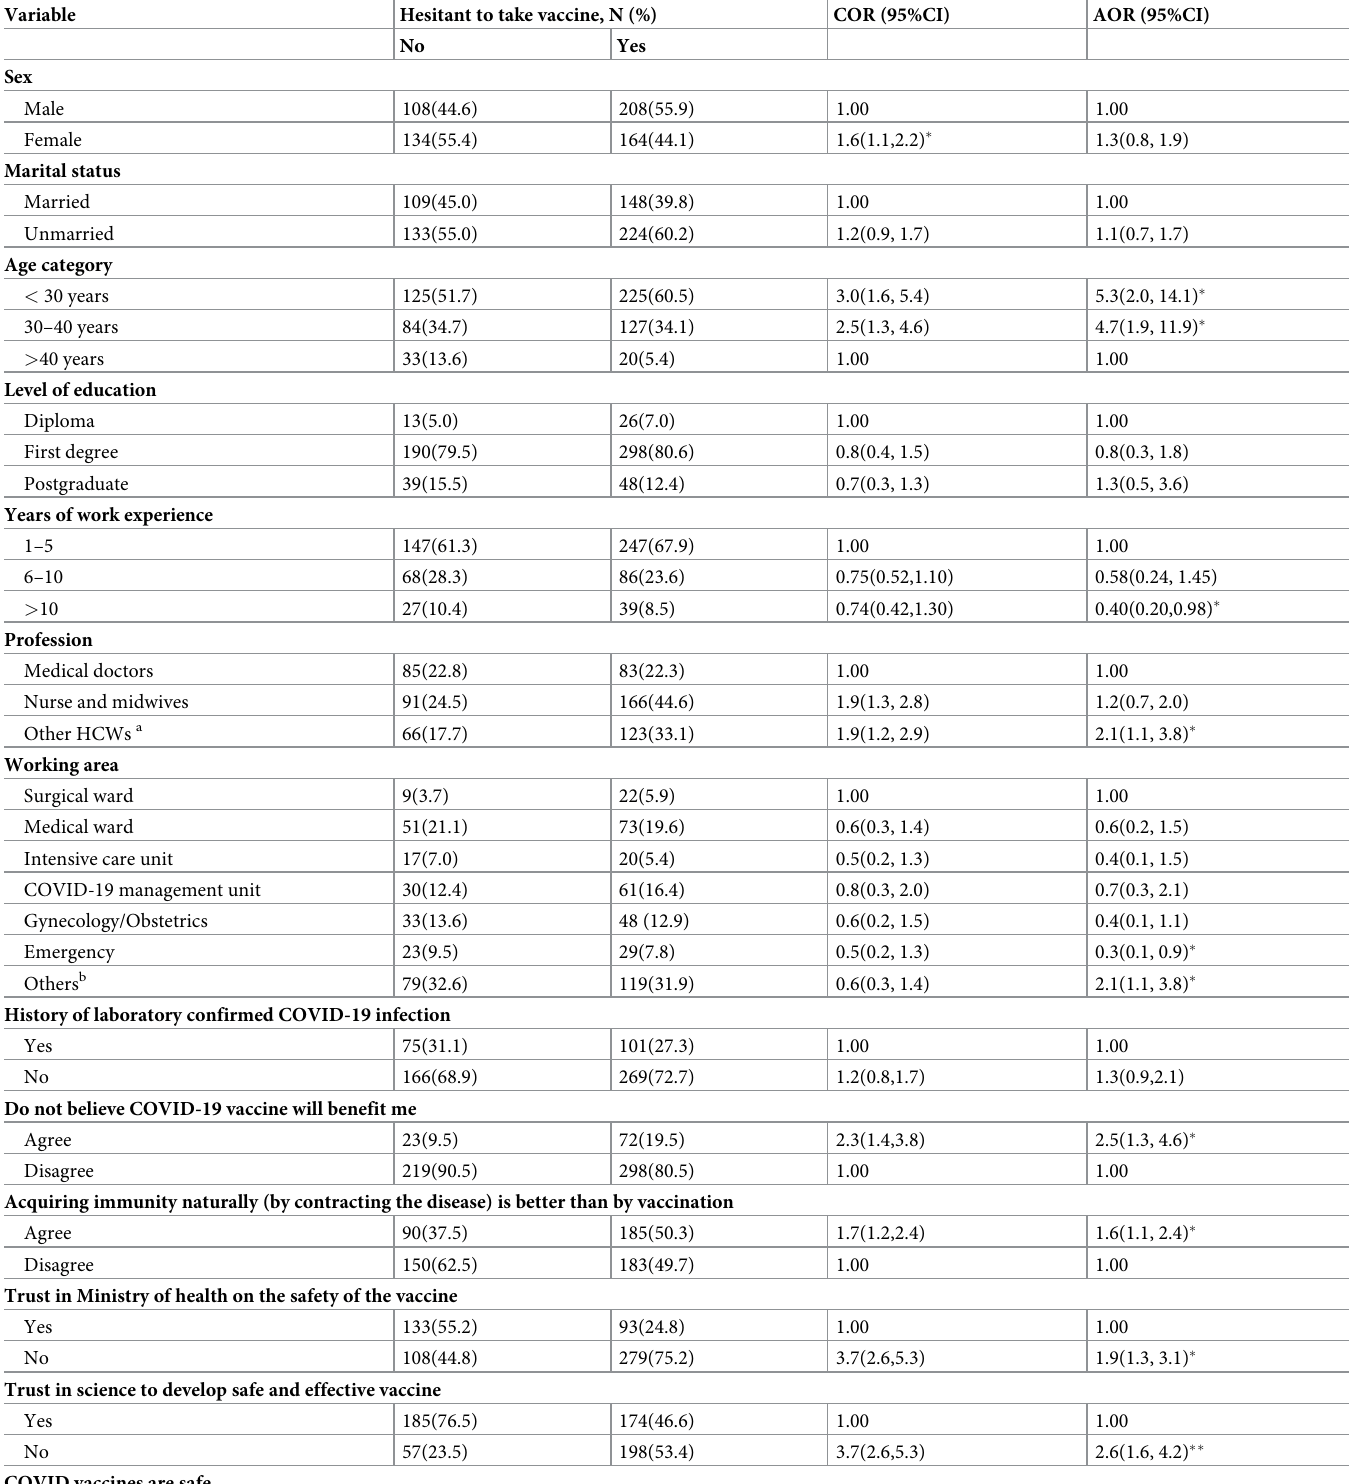
Table 6. Variables associated with COVID-19 vaccine